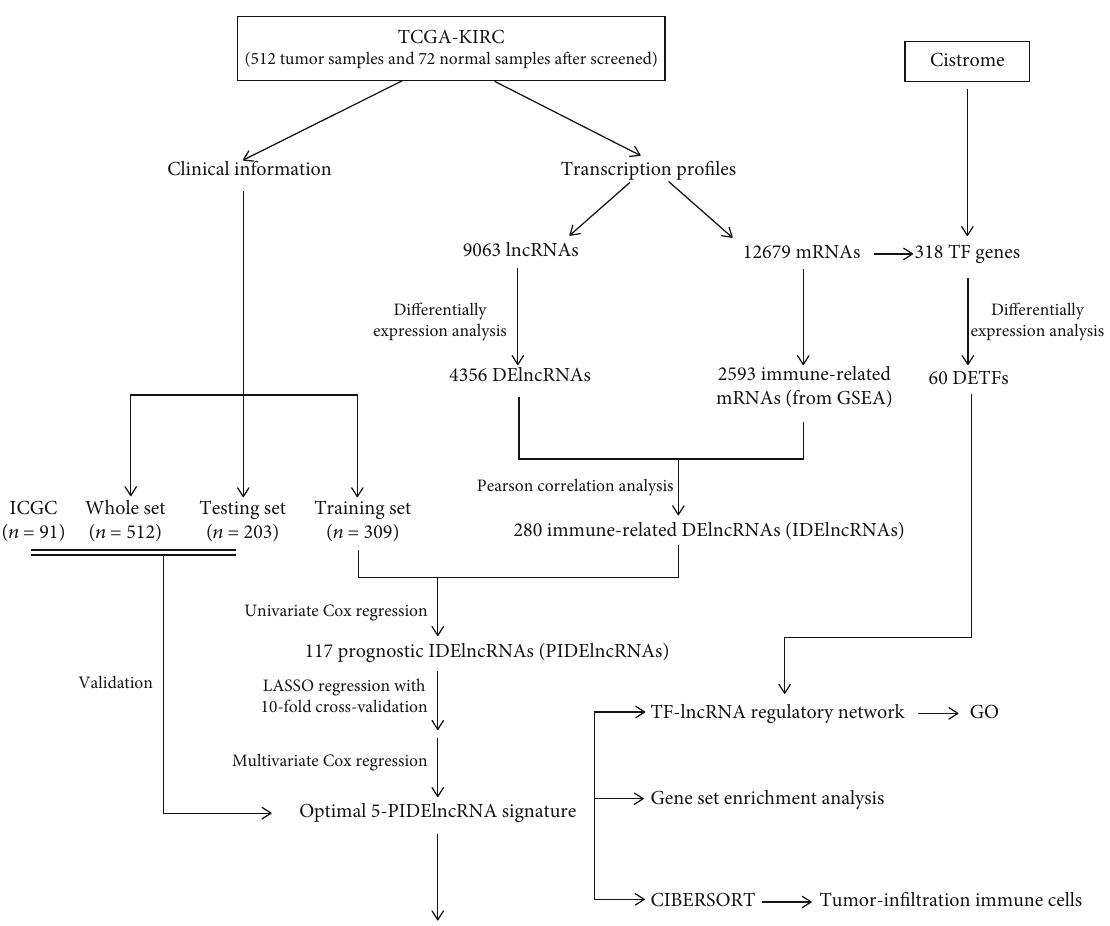
Figure 1: Flowchart of the whole